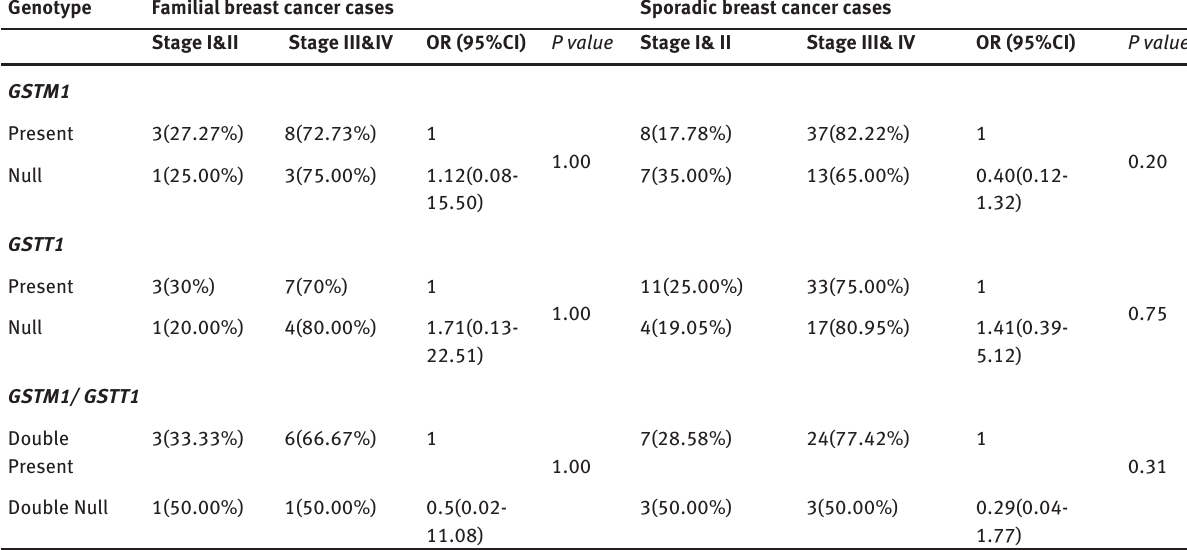
Table 3 : Association of GSTM1 and GSTT1 genotypes with the disease stage of familial and sporadic breast cancer patients. Genotype Familial breast cancer